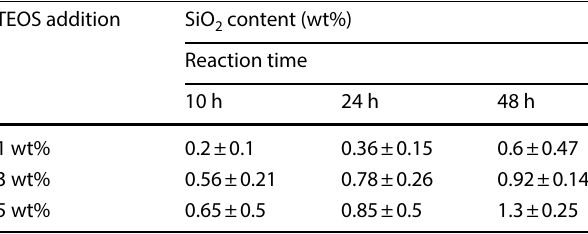
content for silver powders after coating with various Table 2 SiO 2 amounts of TEOS (results based on EDS) TEOS addition SiO content (wt%) 2